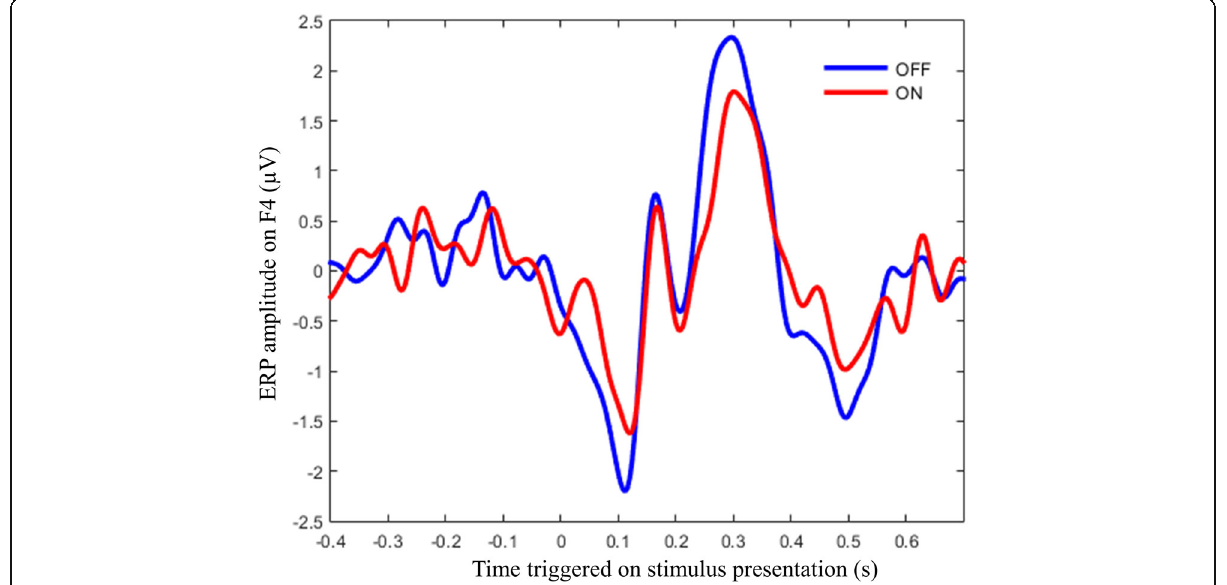
Fig. 3 Modulation of a cognitive ERP by DBS. This plot shows a grand average over 12 OCD patients stimulated in the STN at 130 Hz of the ERP in right fronto-central electrodes during a stop signal task. The amplitude of the ERP was reduced when the stimulation was ON (red) vs. when it was OFF (blue). See (Kibleur et al. 2016) for full description of the data acquisition